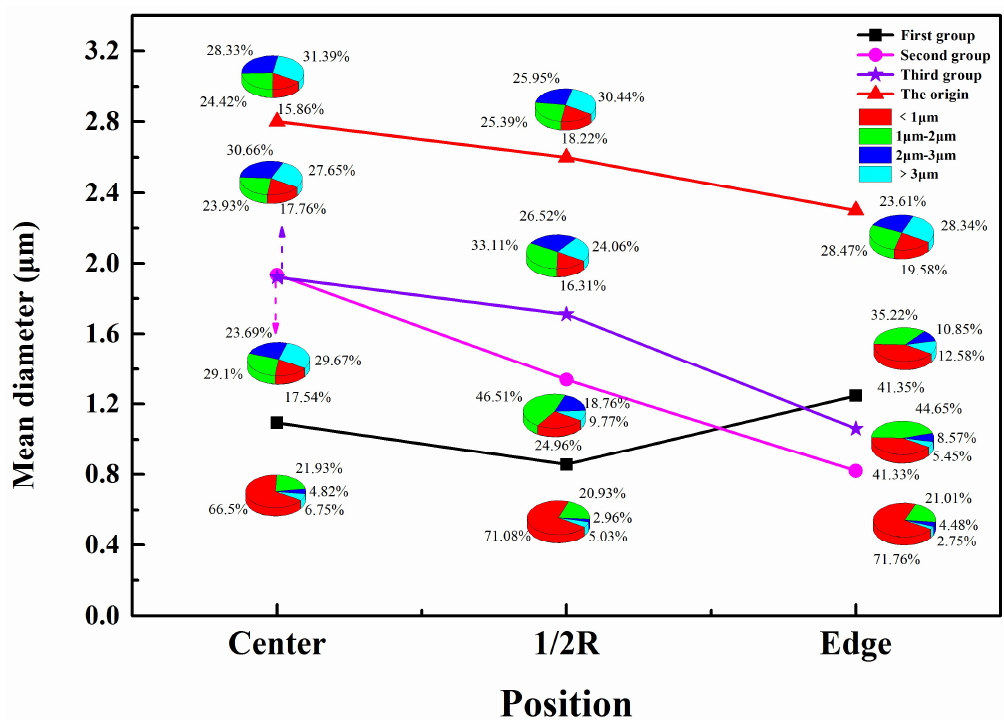
Figure 5. Inclusion distributions in transverse direction for samples obtained using three hot working methods and original sample.